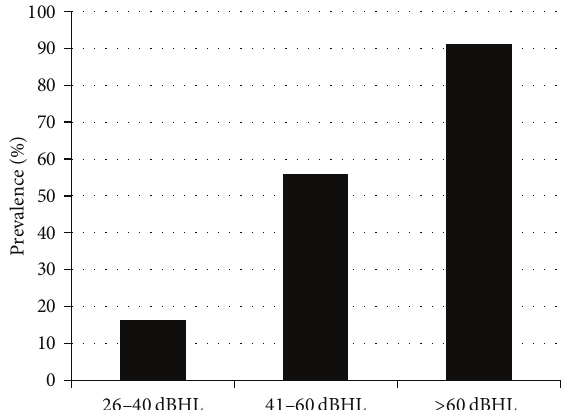
Figure 1: Prevalence of hearing aid ownership for individuals with a mild (26–45dBHL), moderate (46–60dBHL), and sever-profound ( > 60dBHL) hearing loss. Data from Hartley et al. [35].